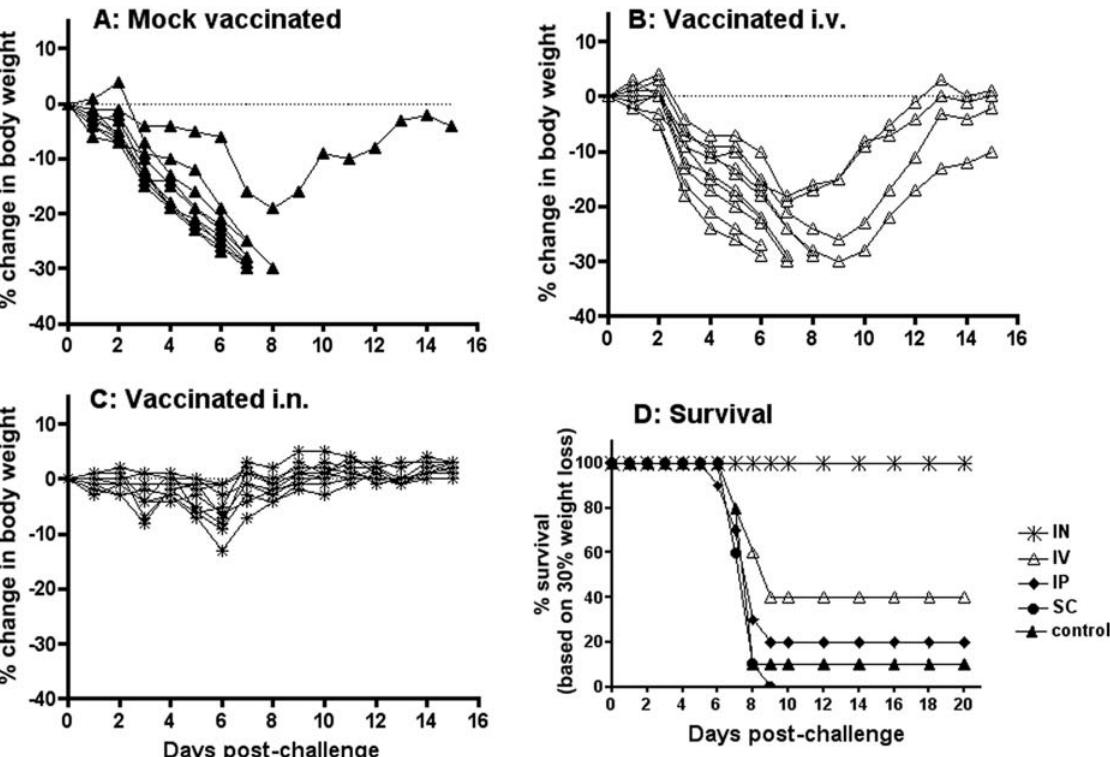
Figure 2. Intranasal vaccination with c 2 Flu provides superior protection to heterotypic virus challenge. Groups of 10 BALB/c mice were either mock treated (A) or vaccinated with c 2 A/PC (3.2 6 10 6 PFU equivalents) intravenously (B) or intranasally (C). Mice were challenged intranasally after 3 weeks with a lethal dose (6 6 10 2 PFU) of A/PR8 and weight recorded daily for 21 days. Survival (D) of mice mock treated, or vaccinated i.n., i.v., i.p., or s.c. and challenged as for (A–C) and monitored for 21